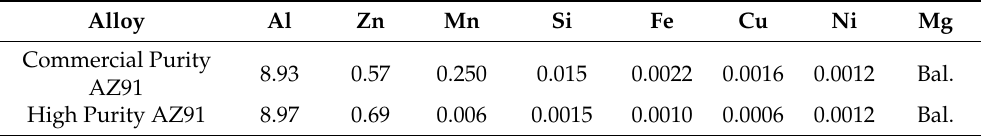
Table 1. Chemical compositions of the commercial-purity and high-purity AZ91